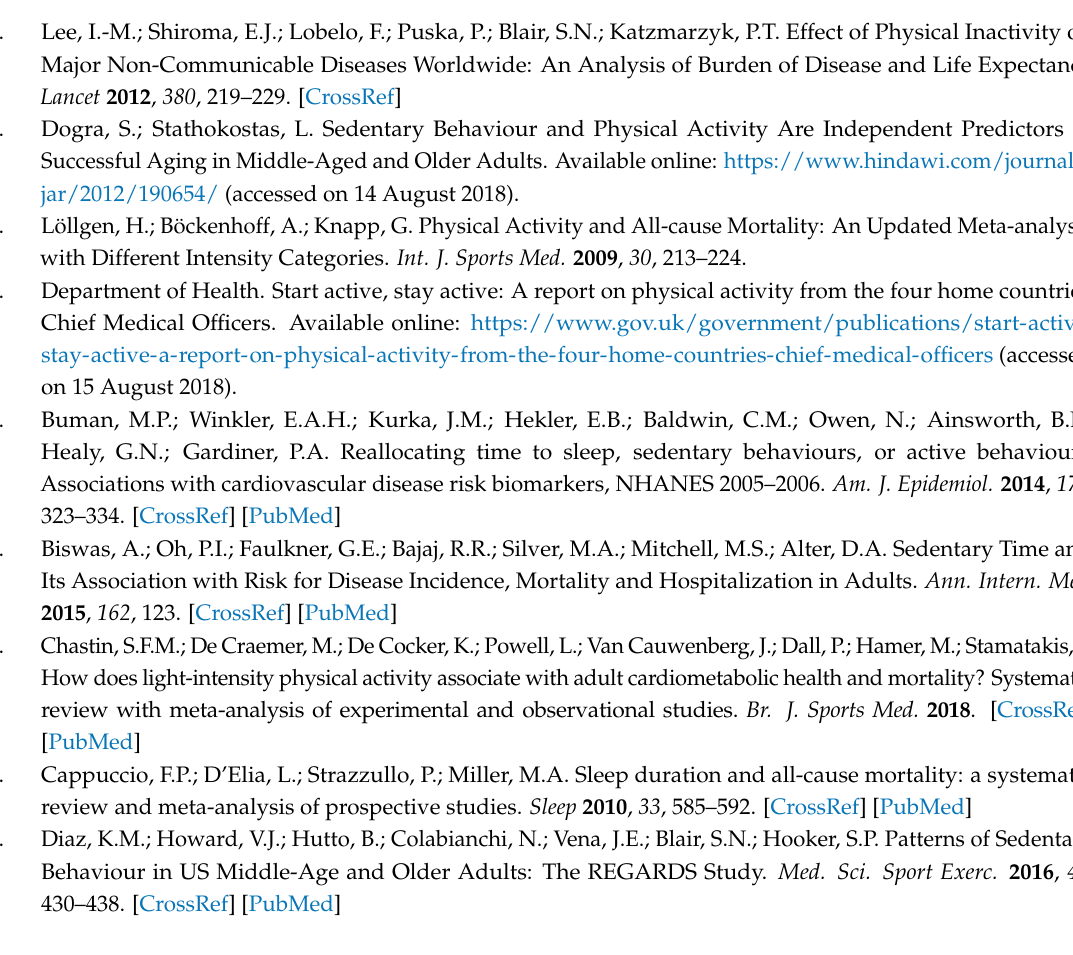
average time-use composition at the zero